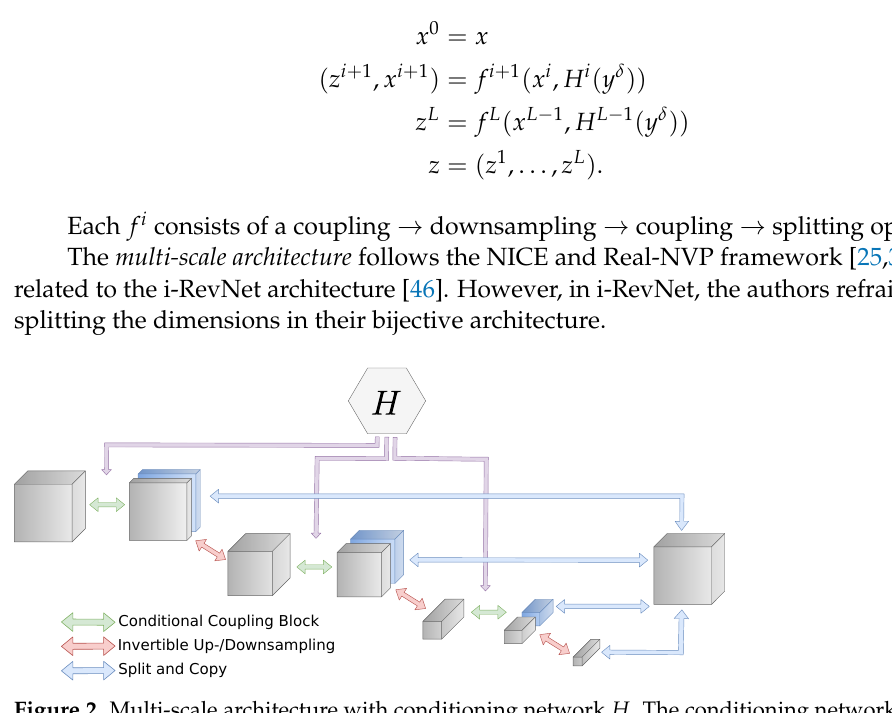
Figure 2. Multi-scale architecture with conditioning network H . The conditioning network processes the conditioning input y δ and outputs this to the respective conditional coupling